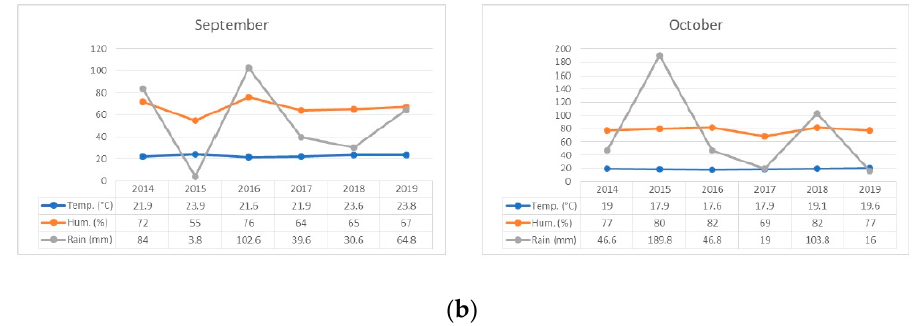
Figure 14. Weather conditions between 2014 and 2019: ( a ) The comparison between temperature, humidity, and rainfall statues in September and October during the years 2014, 2015, 2016, 2017, 2018, and 2019; ( b ) The weather conditions concerning the temperature, humidity, and rainfall between the years 2014 and 2019 extracted from [71].